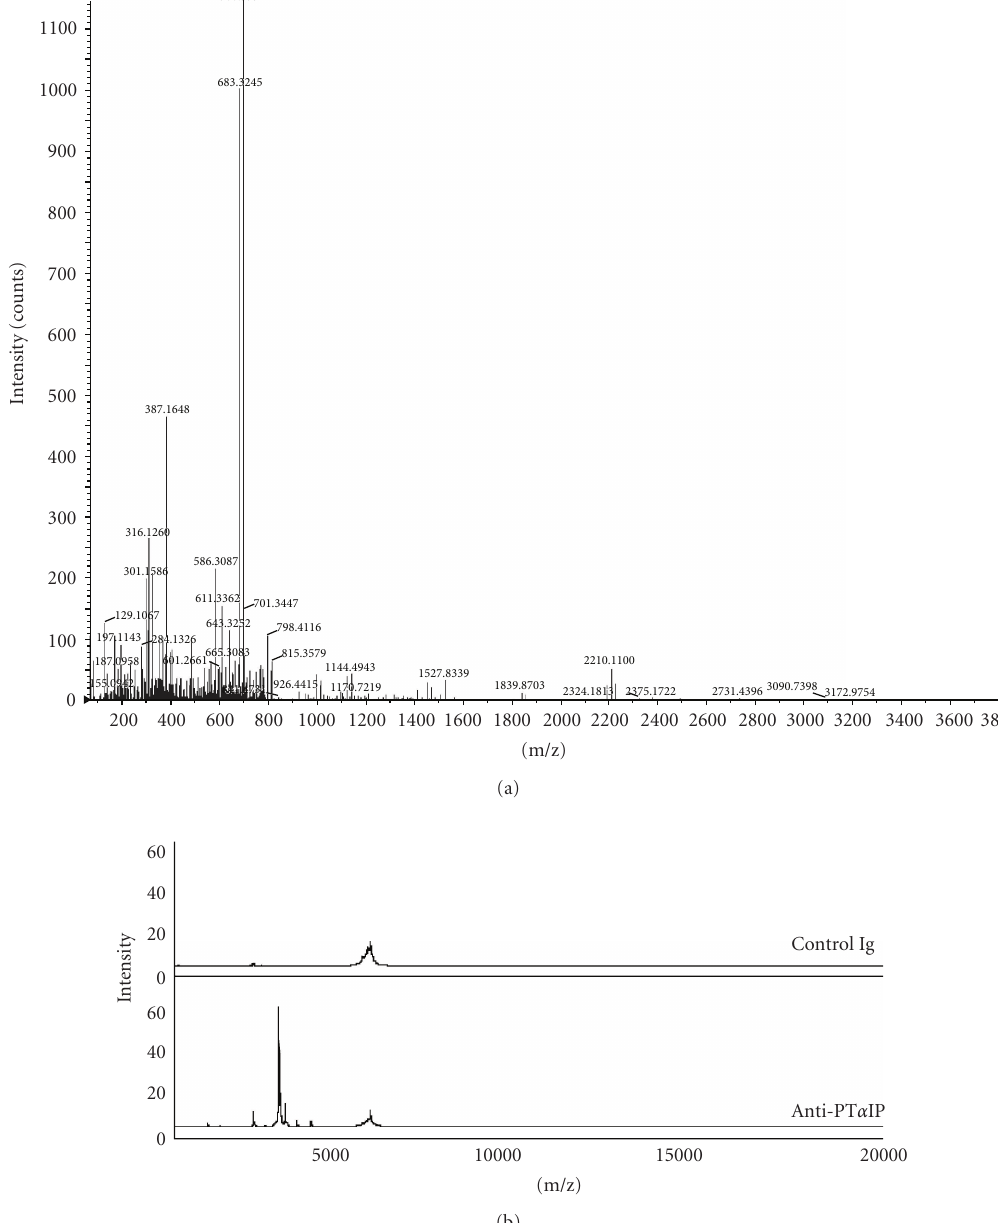
Figure 4: (a) The peptide with m/z approximately 3790 was identified as the fragment of prothymosin alpha by the following MS/MS microsequencing. (b) Mass spectrum of proteins pulled out from cytoplasmic fraction of murine macrophage samples by antiprothymosin alpha which was coupled to protein G agarose beads (mass range from 1000 to 20,000 m/z). Antiprothymosin alpha-coupled protein G agarose beads were incubated with cytoplasmic fraction and eluted proteins were analyzed on NP 20 ProteinChip